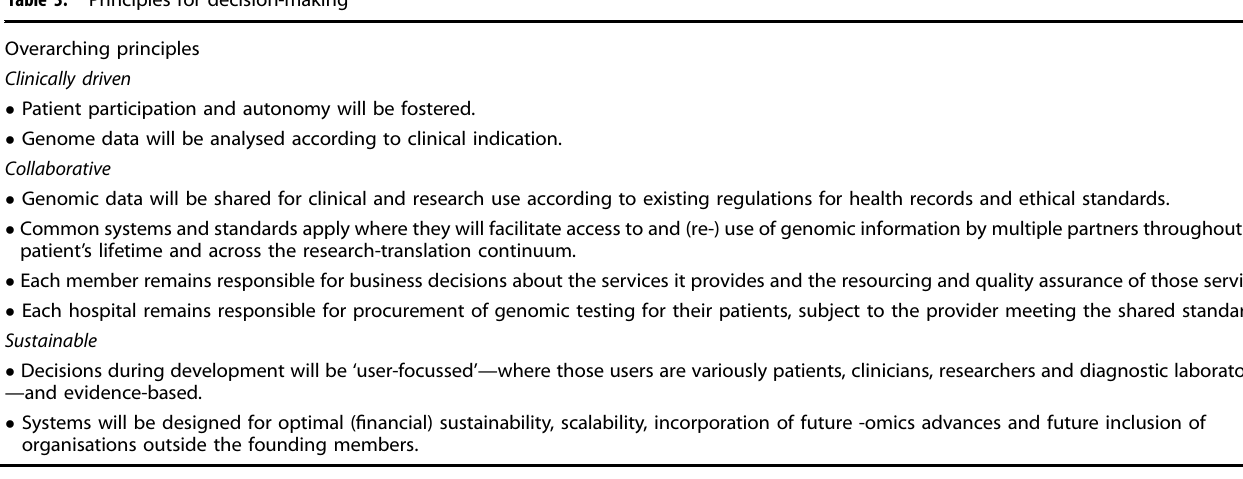
Table 3. Principles for decision-making Overarching principles Clinically